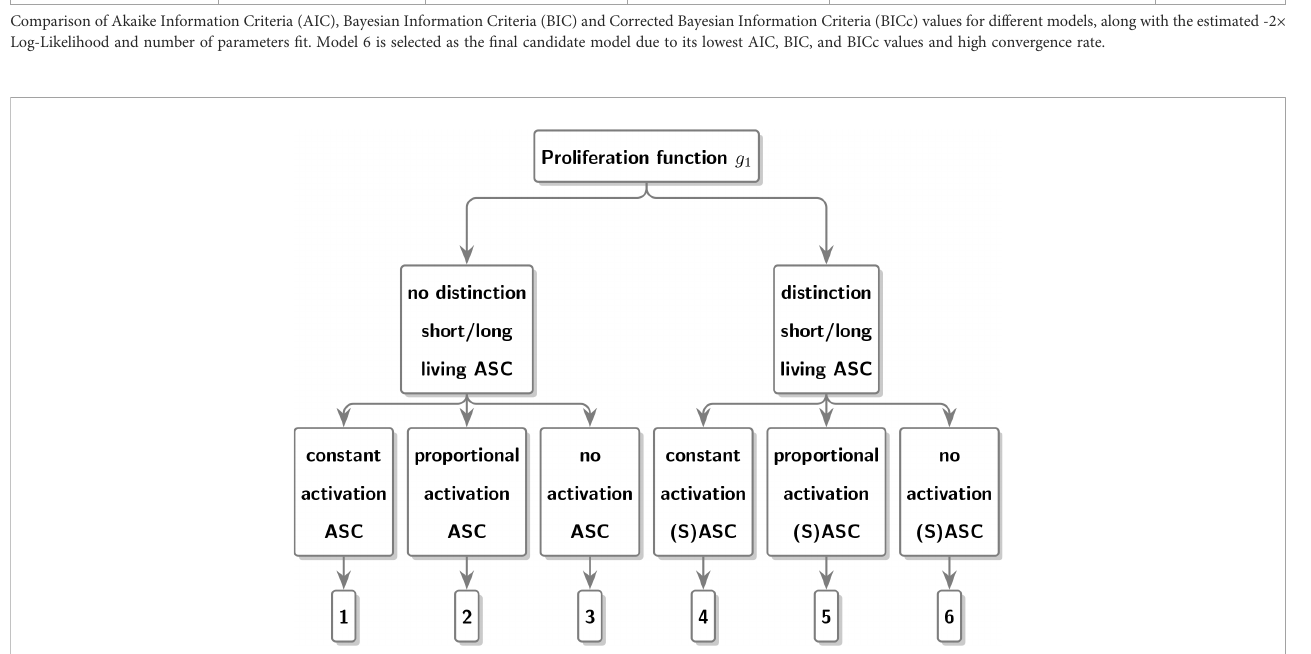
FIGURE 2 Schematic diagram depicting the different proliferation functions used to characterize antibody dynamics in the different models.